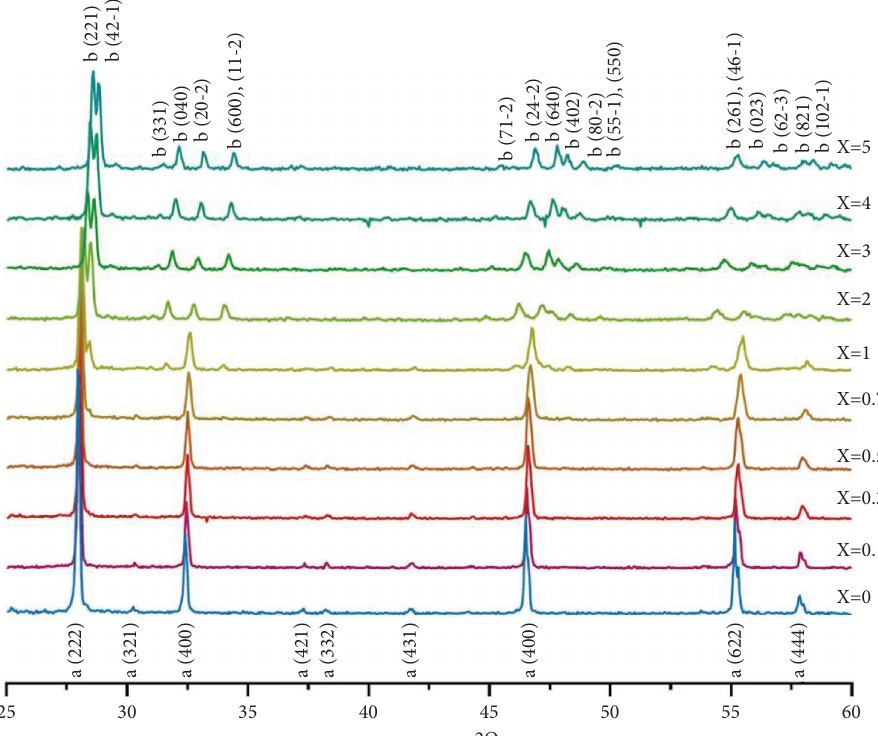
Figure 1: X-ray powder difraction patterns of the Nd